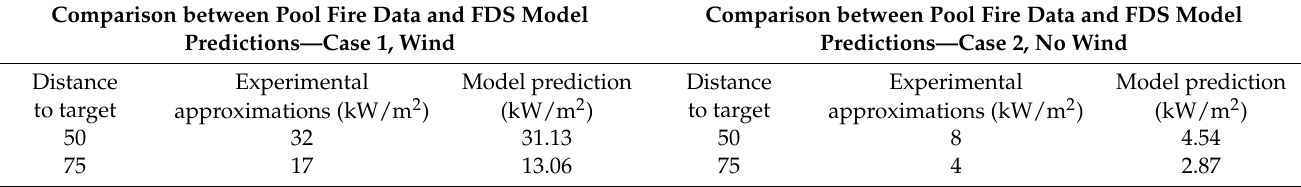
Table 2. Comparison of the FDS model predictions and the actual fire data in the wind and nonwind scenarios [50]. Comparison between Pool Fire Data and FDS